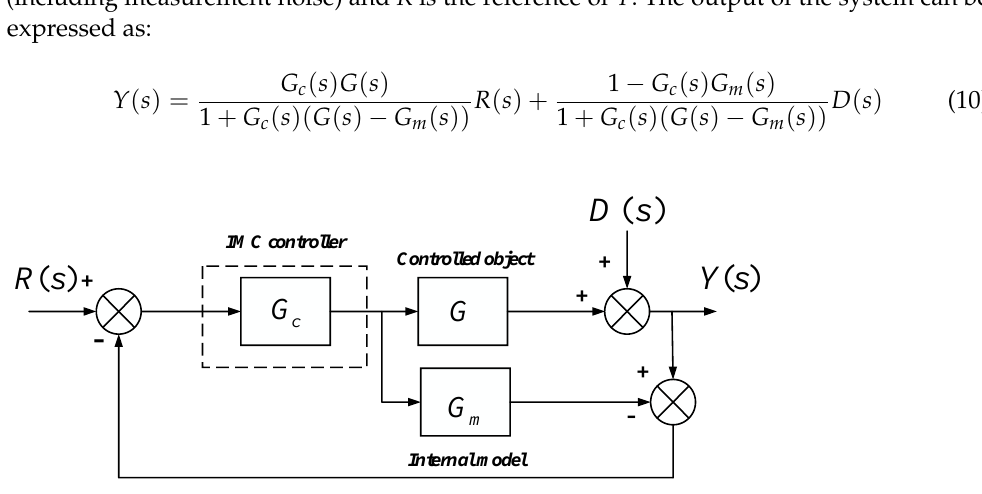
Figure 5. General structure of IMC.